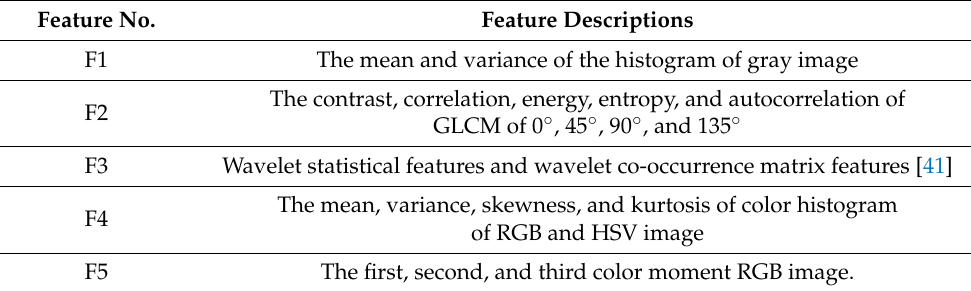
Table 6. Feature descriptions for experimental evaluation. Feature